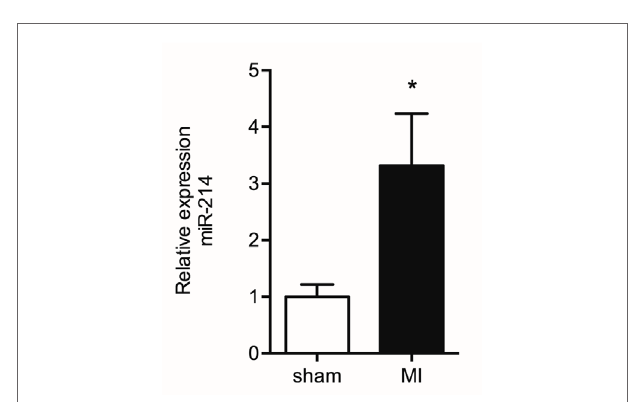
FigUre 2 | increased mir-214 expression in the post-Mi lV . Mir-214 expression levels were determined by quantitative RT PCR analysis in remote LV tissue from sham and MI animals isolated at day 7 post surgery. U6 snRNA expression levels were used as correction factor. Values are means ± SEM, n = 6, normalized to the sham level, * p < 0.05.